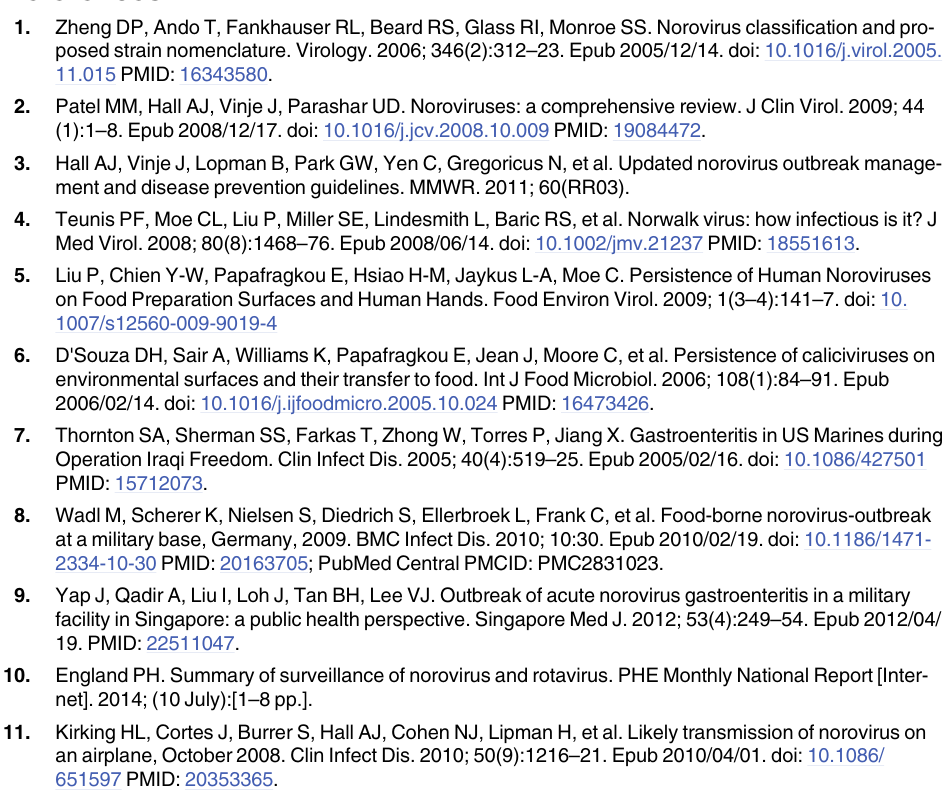
S1 Fig. Mean size of capsids and/or